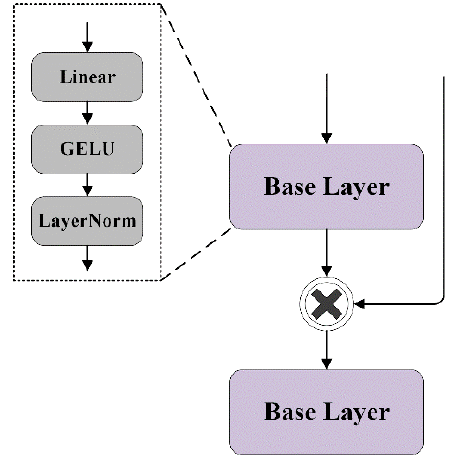
Figure 13. Feature fusion layer.